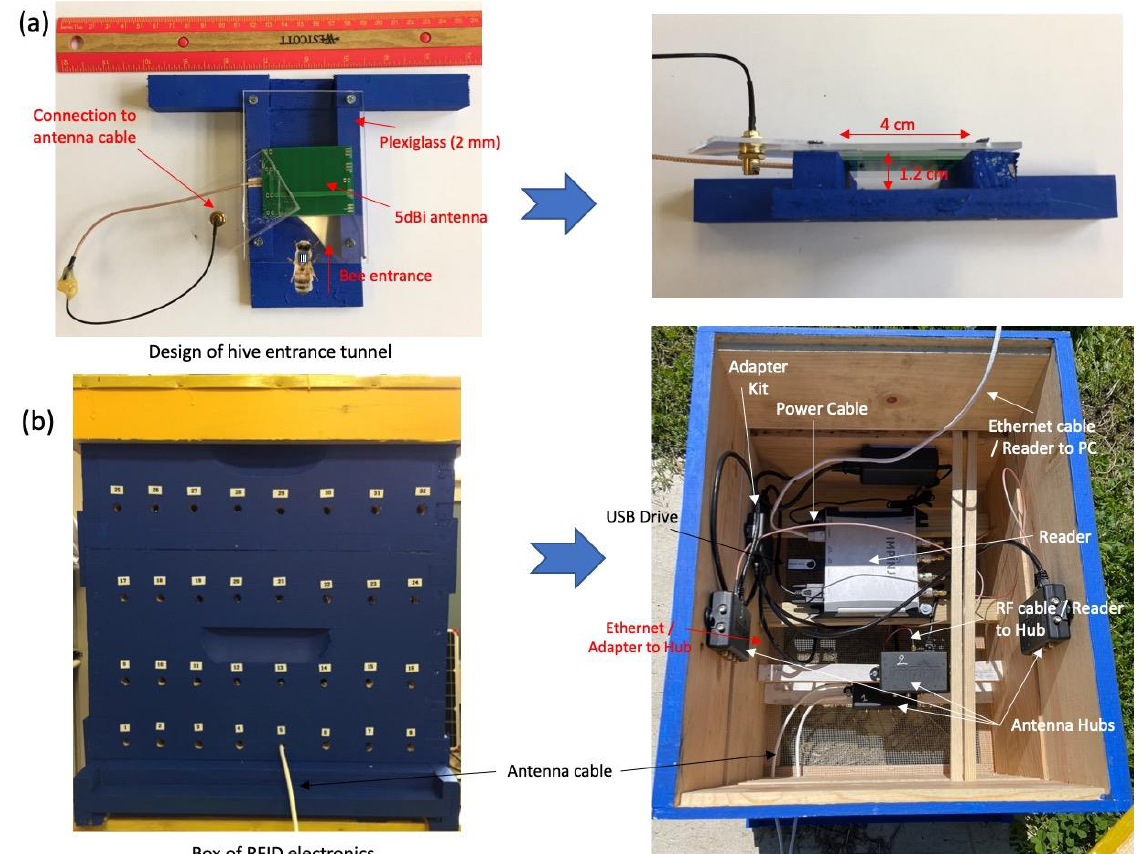
Figure 3. Modification and wiring required to operate the RFID 32-antenna unit. ( a ) shows the optimal tunnel parameters required to accommodate a 5 dBi antenna to identify and read the bee’s transponder. ( b ) explains the wiring of the various RFID items (reader, hubs, and adapter) located within the designated box. For clarity and simplicity, we only displayed the wiring of two antennas.